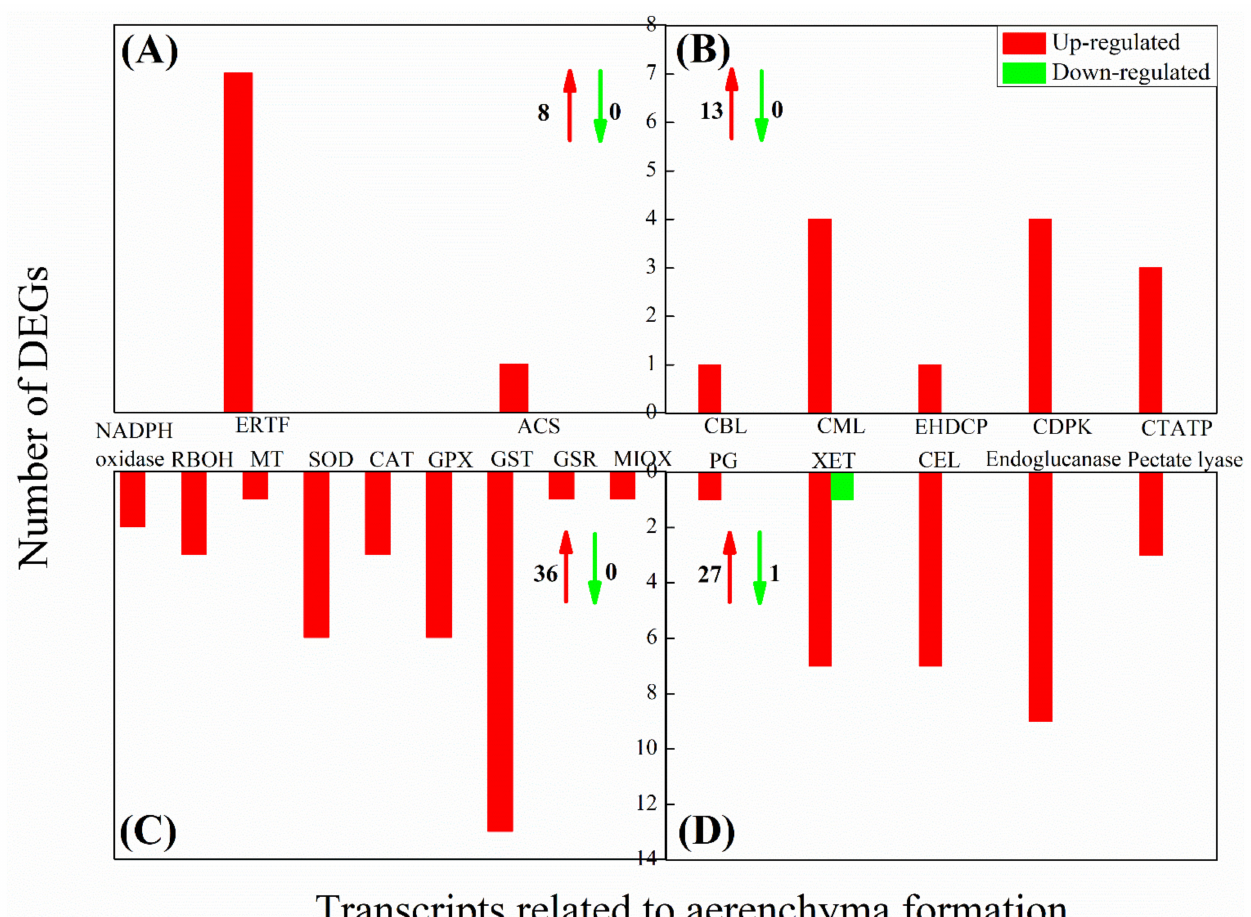
Figure 6. The expression of differentially expressed genes (DEGs) related to aerenchyma formation (ethylene signaling ( A ), calcium signaling ( B ), ROS generation/scavenging ( C ), and cell wall modification ( D )) in underground tissues of bermudagrass under shallow submergence (SS). ERTF: ethylene-responsive transcription factor; ACS: 1-aminocyclopropane- 1-carboxylic acid synthase; CBL: calcineurin B-like protein; CML: calcium-binding proteins and calmodulin-like protein; EHDCP: EH domain-containing protein; CDPK: calcium/Calmodulin-dependent protein kinases; CTATP: ca 2+ -transporting ATPase; RBOH: respiratory burst oxidase homolog; MT: metallothionein; SOD: superoxide dismutase; CAT: catalase; GPX: glutathione peroxidase; GST: glutathione S-transferase; GSR: glutathione reductase; MIOX: myo-inositol oxygenase; PG: polygalacturonase; XET: xyloglucan endotransglucosylase; CEL: